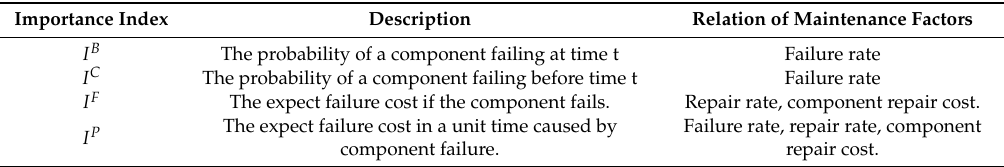
Table 4. The comparisons of the component reliability importance indices.